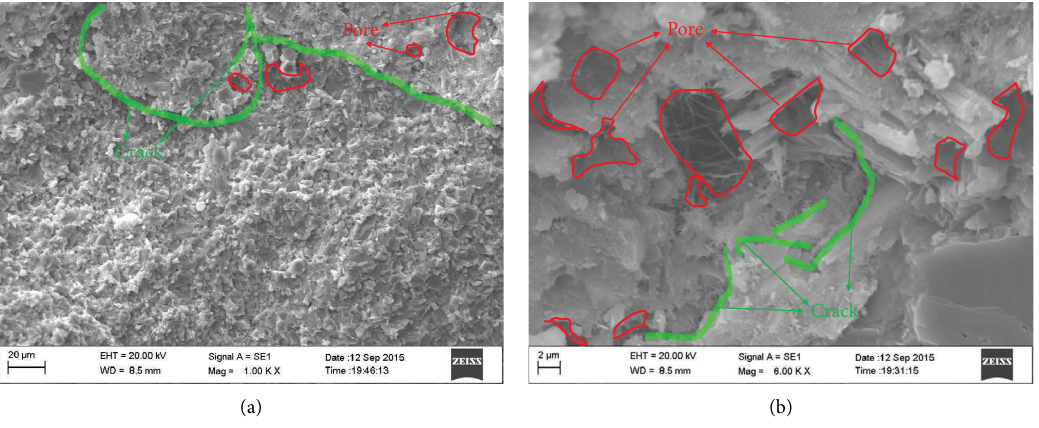
Figure 11: SEM-FC0: (a) 20 μ m and (b) 2 μ m.